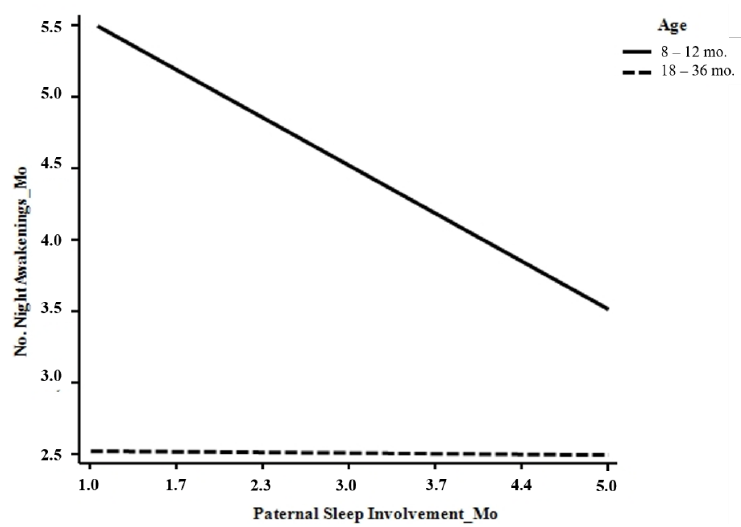
Figure 2. Links between paternal sleep involvement and the number of night awakenings reported by mothers. Int. J. Environ. Res. Public Health 2020 , 17 , x